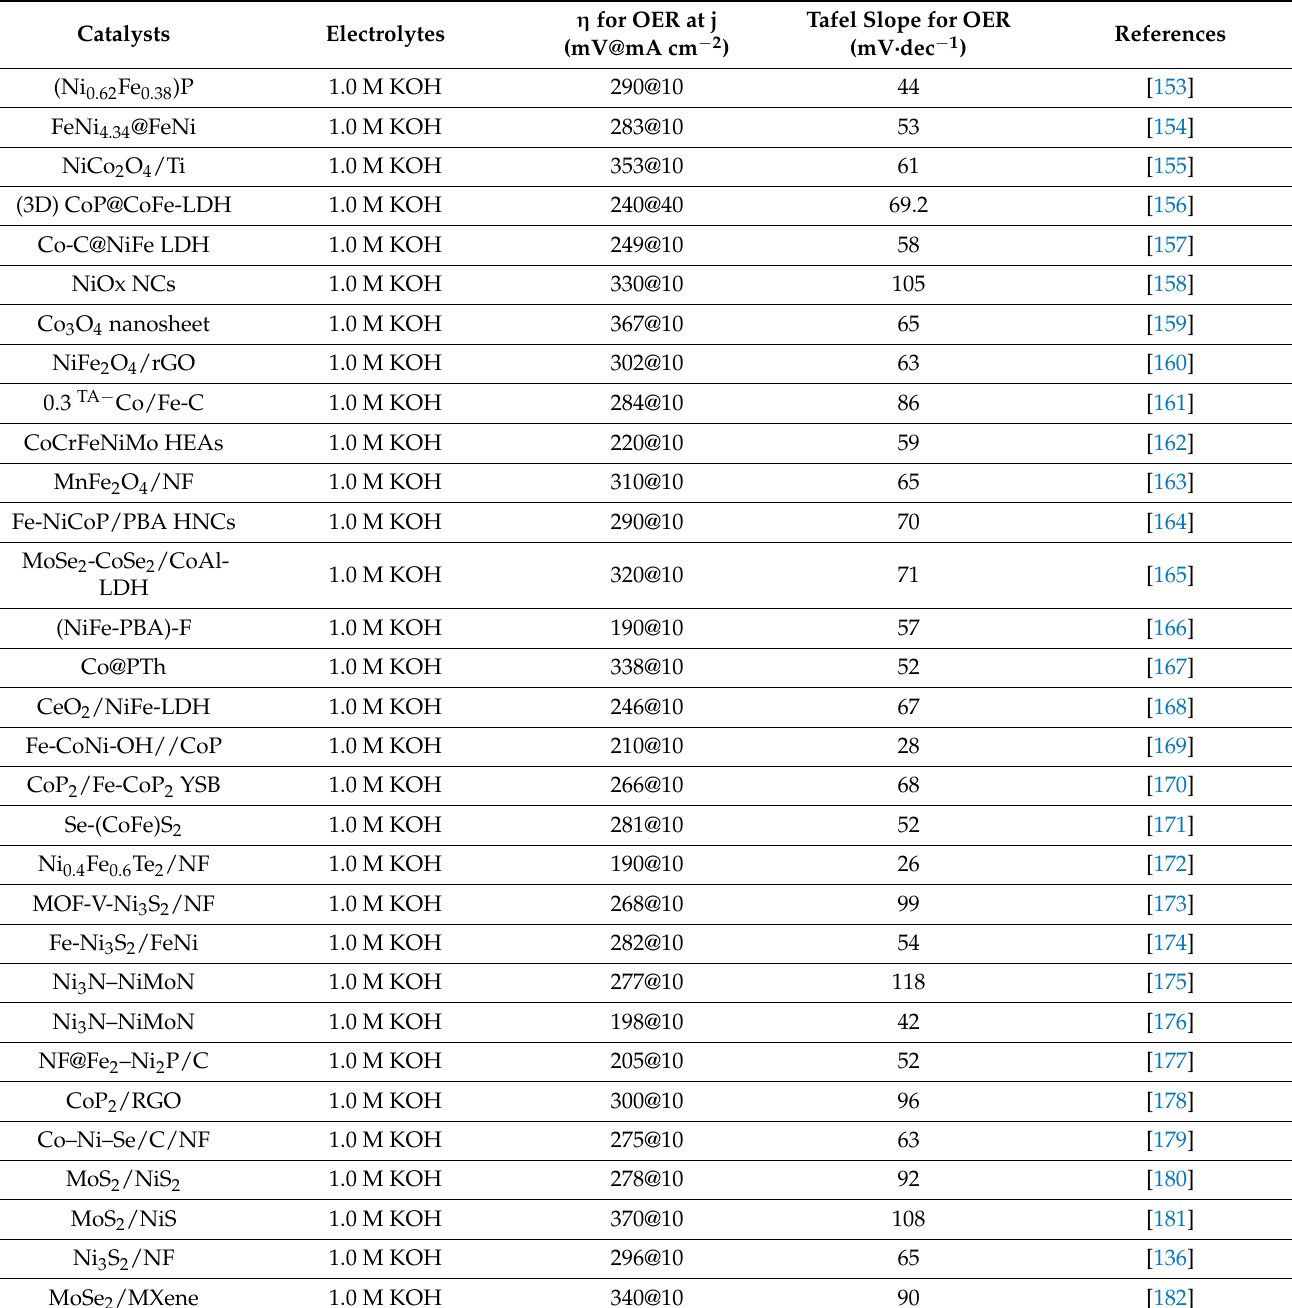
Table 2. The overview of the oxygen evolution reaction (OER) performances of recently recorded electrocatalysts for water